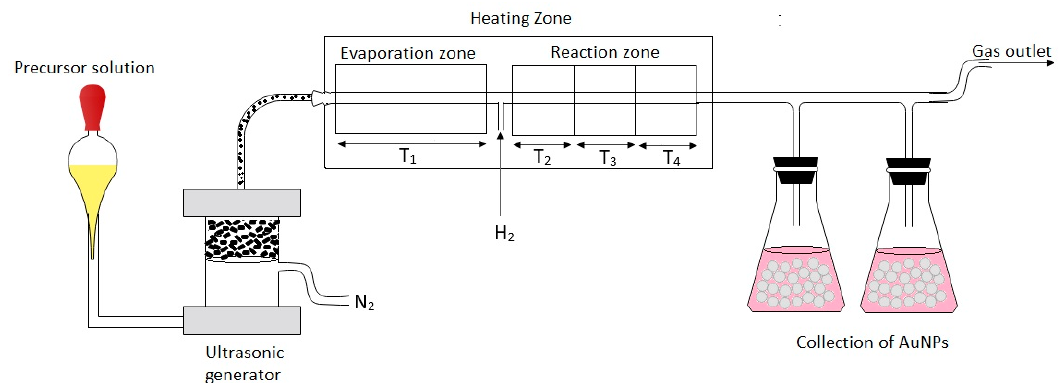
Figure 1. Modified Ultrasonic Spray Pyrolysis (USP) for AuNPs` synthesis.